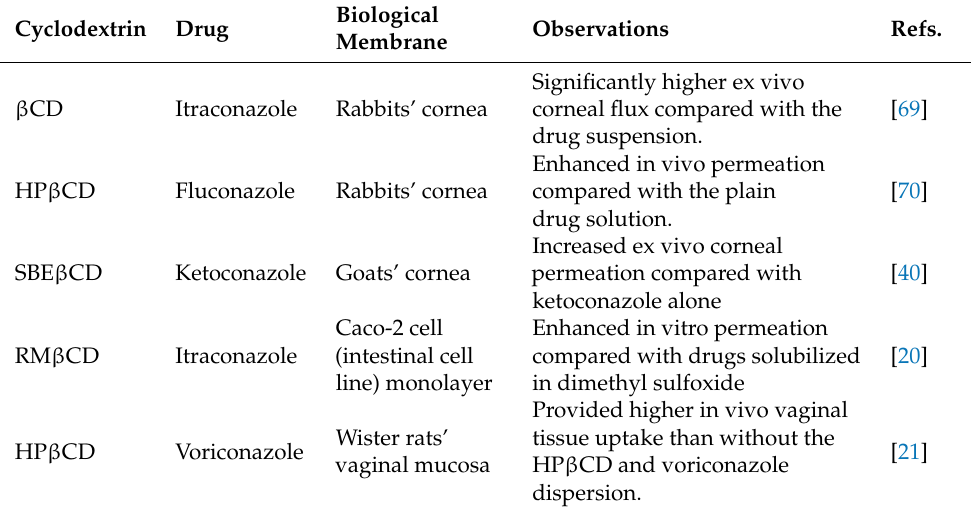
Table 3. Observations of CDs enhancing the permeability of antifungals through biological mem- branes in vitro, ex vivo, and in vivo